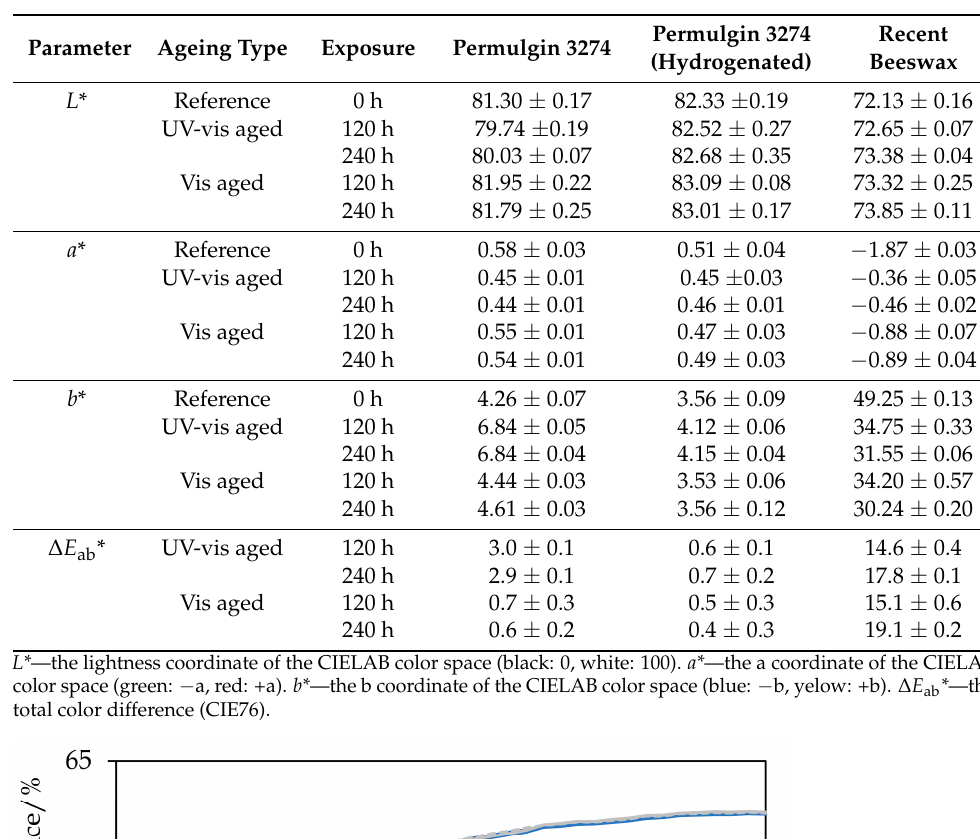
Table 5. The parameters L *, a *, b * and the total colour difference of samples after the exposure to UV-vis and visible radiation for 120 and 240 h respectively. The data were expressed as mean ± standard deviation. ∆ E ab * values are related to the unexposed control samples both in the case of 120 h and 240 h exposure.